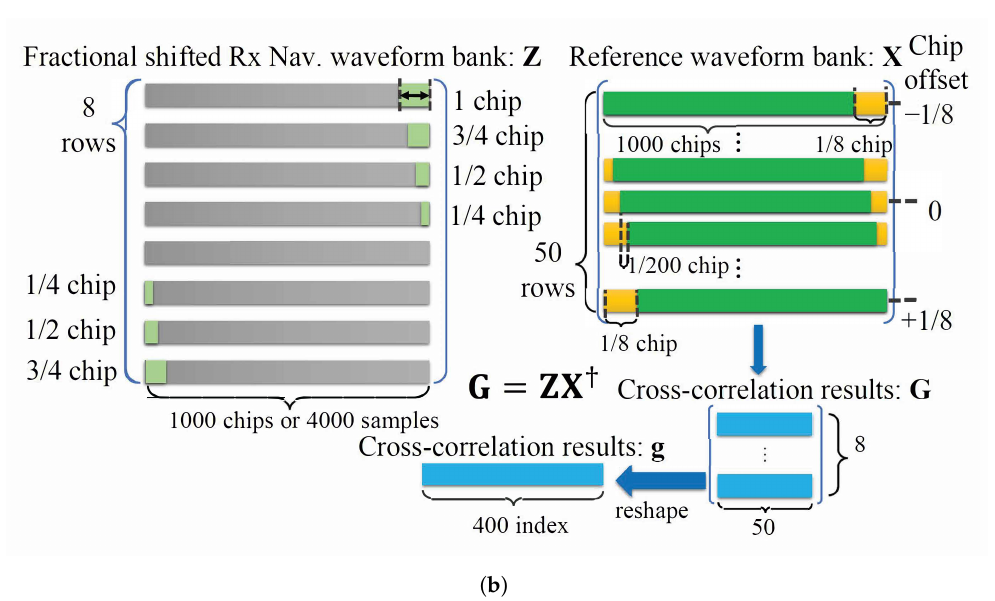
Figure 17. Optimized structure of the fine ToA estimation implementation. ( a ) Construct a micro- shifted version of the reference waveform. The consecutive waveforms are shifted by 1/200th of a chip. ( b ) Memory-efficient subdivision of correlator